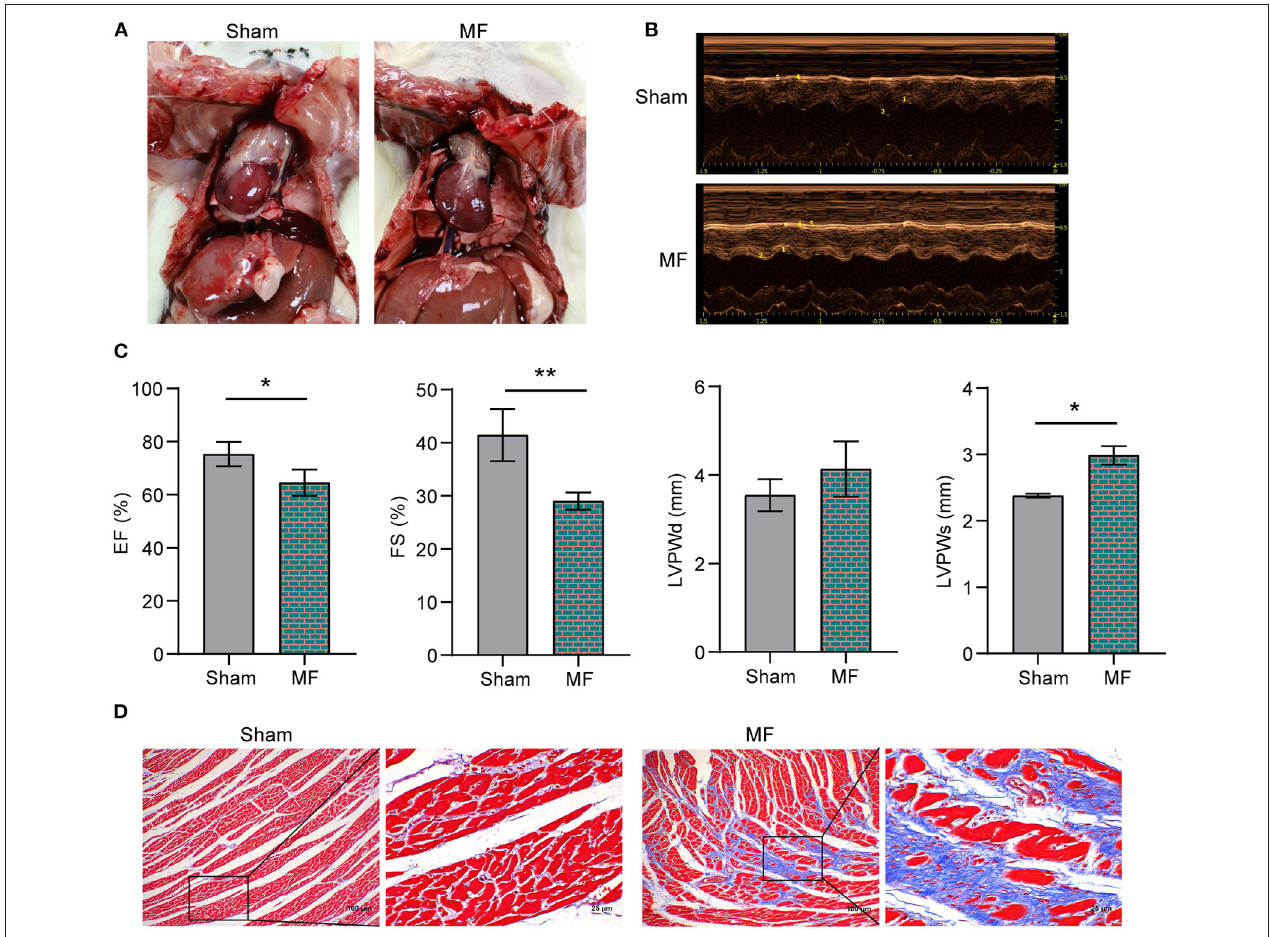
FIGURE 1 | The rat MF model was established successfully. (A) Morphology of the rat heart. (B) Rat echocardiography. (C) EF, FS, LVPWd and LVPWs detection. (D) Masson staining was performed to stain the rat heart tissues ( × 100, 100 µ m; × 400, 25 µ m). * P < 0.05, ** P <